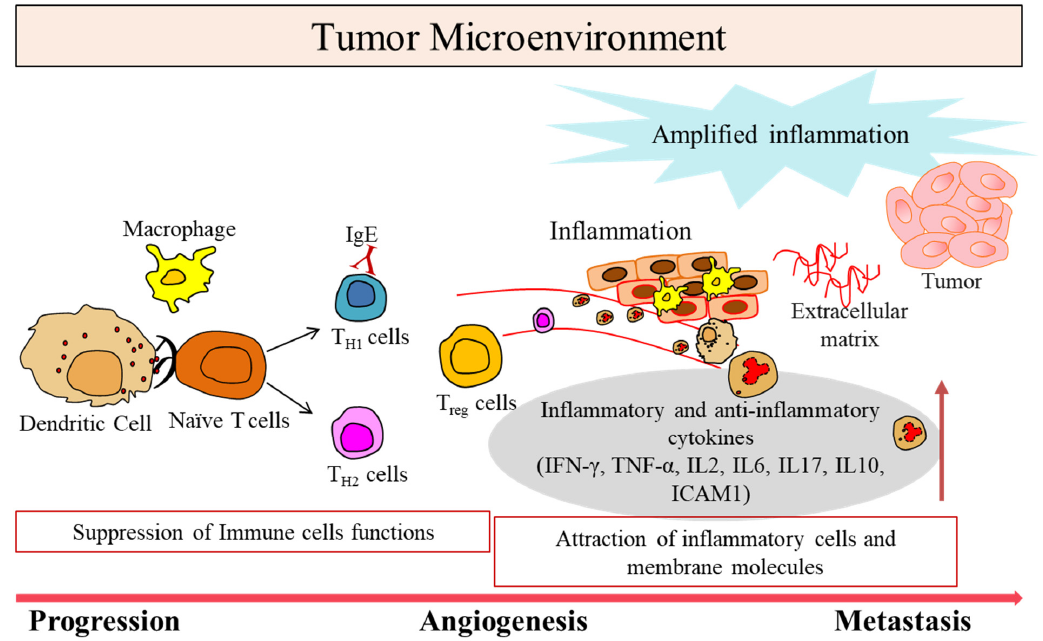
Figure 1. Tumor microenvironment in cancer. Schematic depicting progress of tumor involving sup- pression of immune function, tumor cells proliferation leading to metastasis.